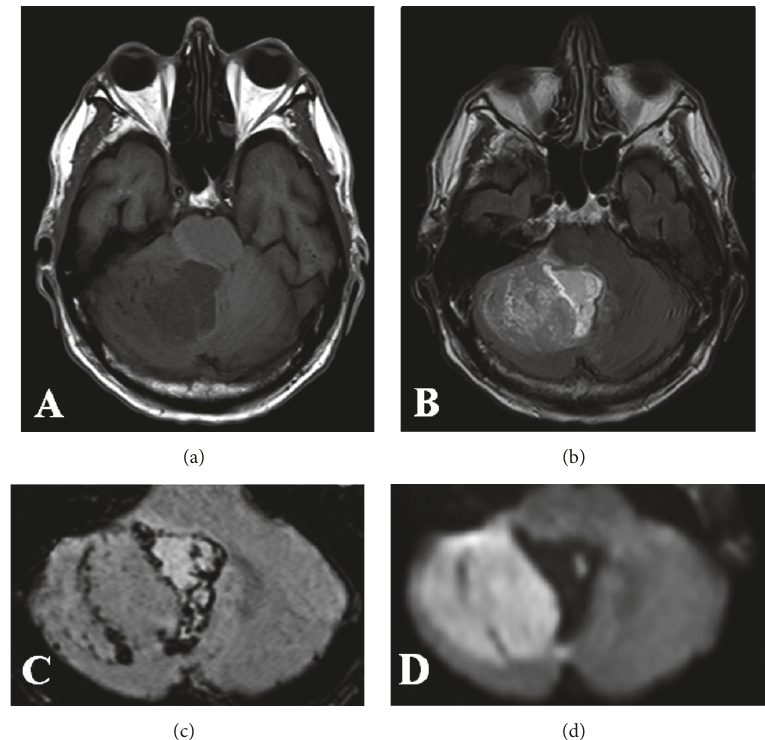
Figure 3: Transversal T1w image at 1.5 Tesla (a) shows a large hypointense tumor of the right cerebellar hemisphere with a hyperintense cyst on FLAIR images (b), which fills most of the fourth ventricle and causes obstructive hydrocephalus (not shown). Susceptibility weighted images (c) reveal hemosiderin deposits in the caudal tumor parts. Because of its dense cellularity, this tumor shows moderate restriction on diffusion weighted images